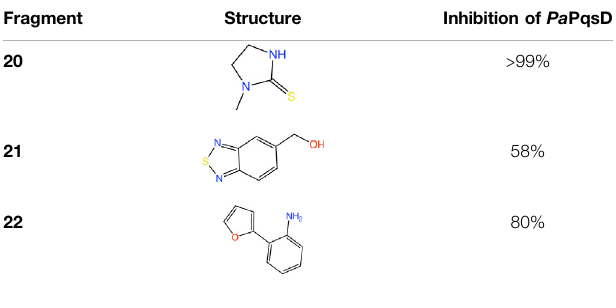
TABLE3| Fragment-likeinhibitors of Pa PqsDobtainedbyaFBDDcampaignwith two fragments showing strong inhibition (85%) of Pa PqsD. Fragment